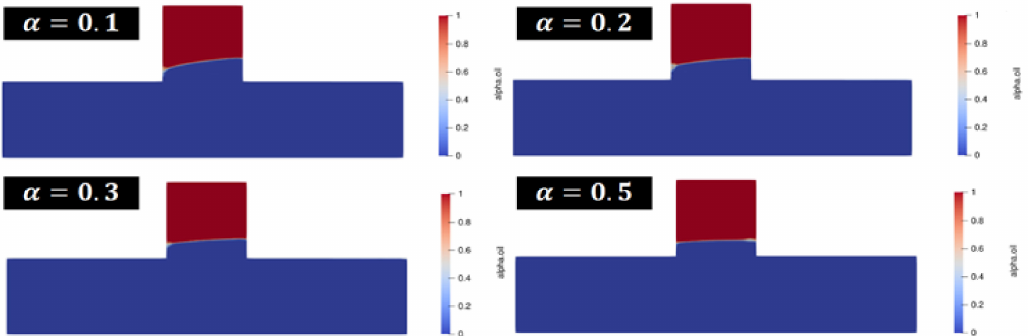
Figure 5. The results of simulation for the polymer flooding.